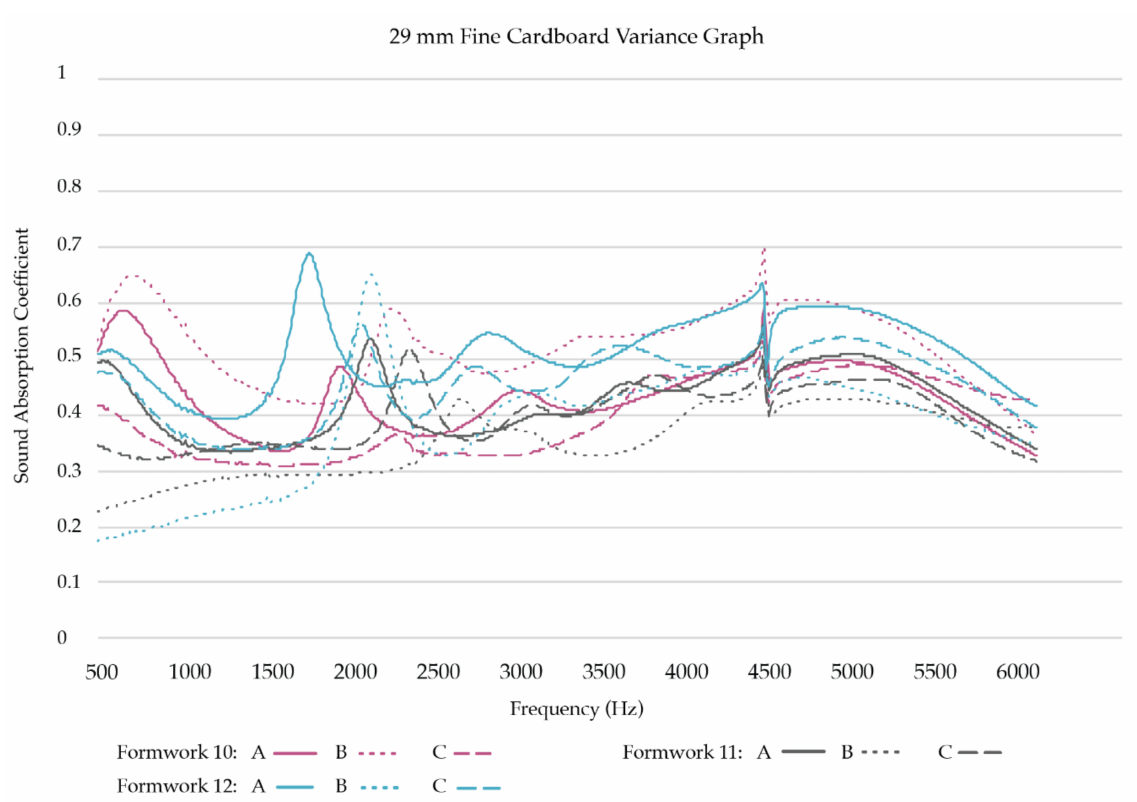
Figure 12. Sound Absorption Coefficients of FCH replicates (29 mm).